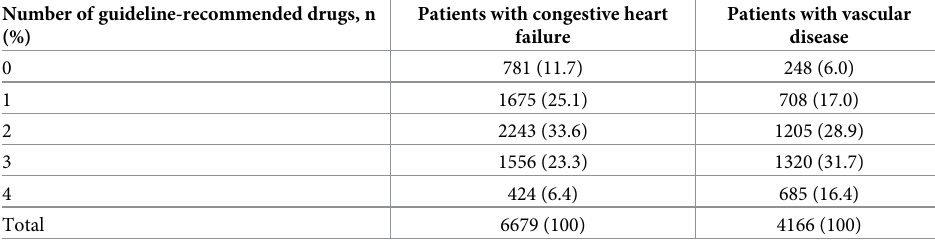
Table 2. Baseline prescription of guideline-recommended therapies in patients with congestive heart failure or vascular disease (cid:3) . Number of guideline-recommended drugs, n